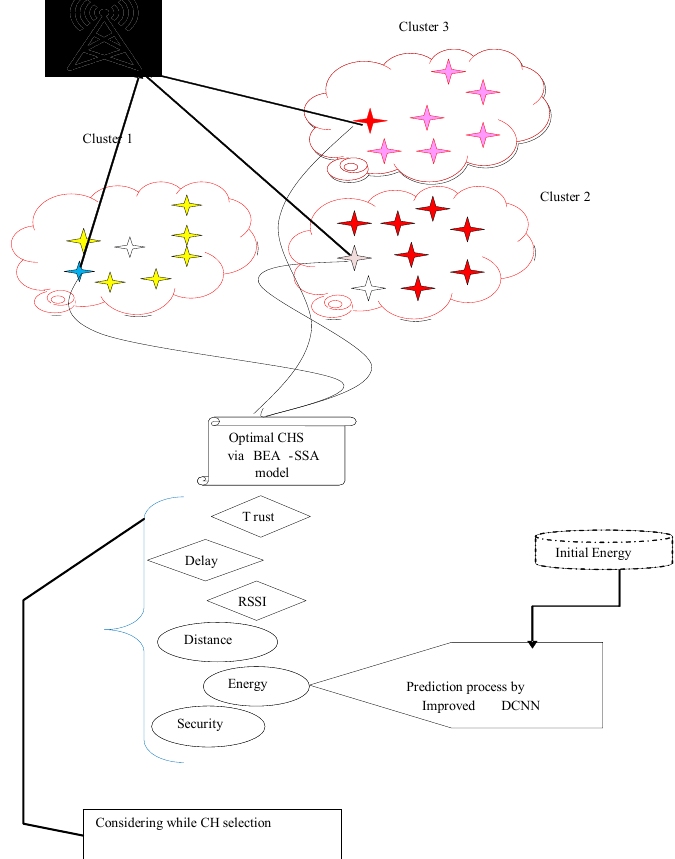
Figure 1. Pictorial representation of the proposed method. Different color star denotes three cluster groups, where cluster head is selected and connected with the base station.